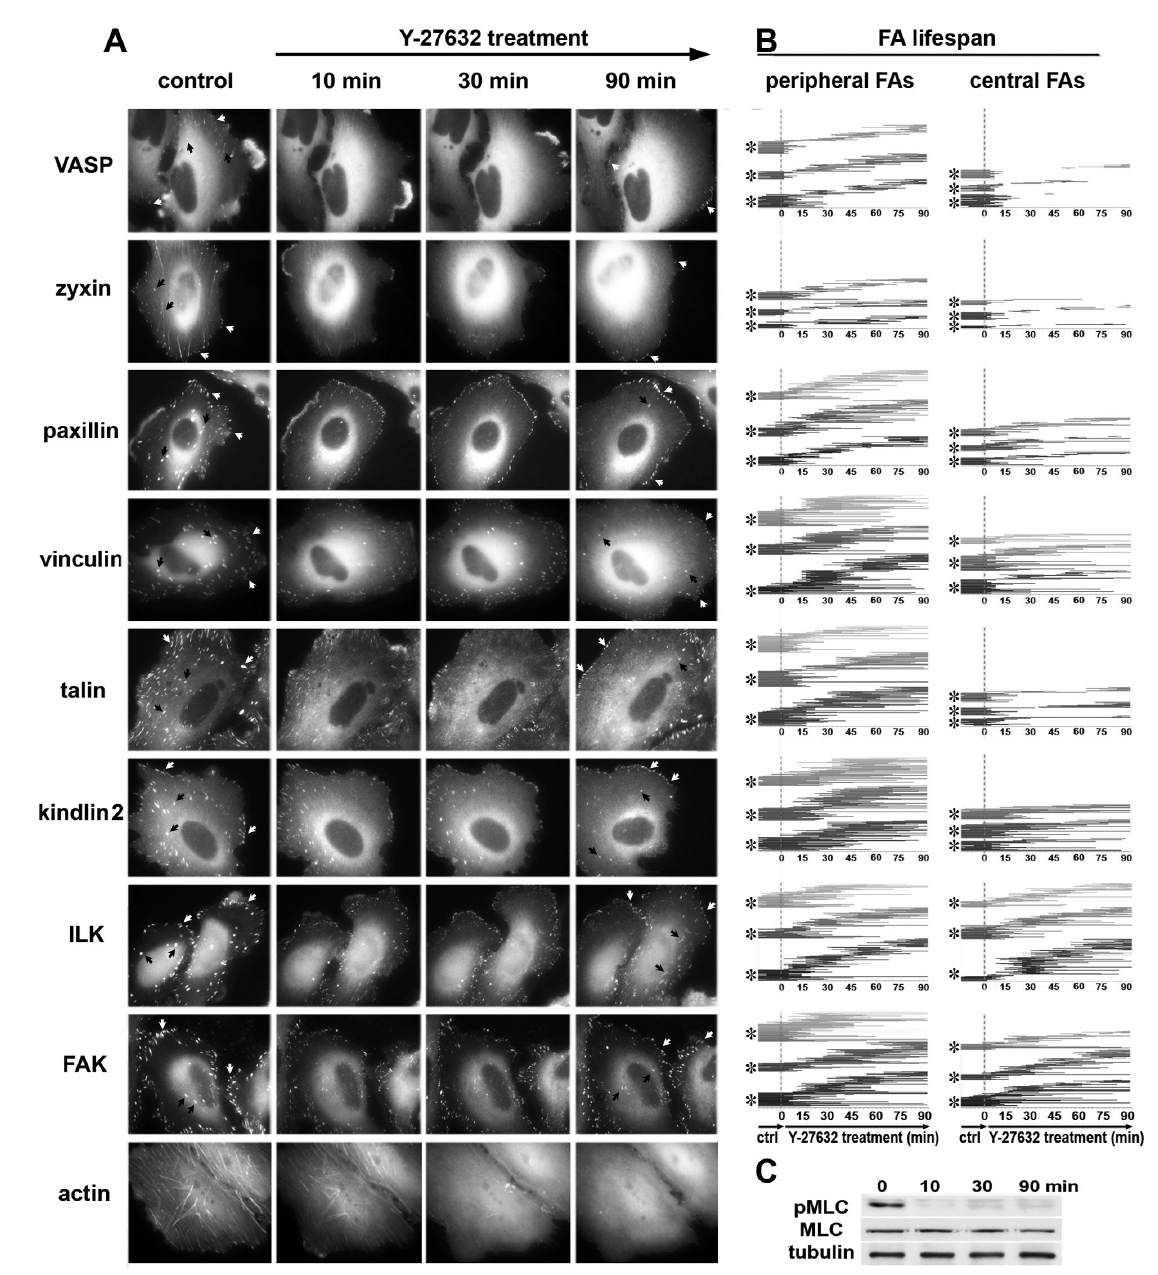
Figure 1. Effect of Y-27632 treatment on FA reorganization in HeLa JW cells. ( A ) Localization of GFP-tagged VASP, zyxin, paxillin, vinculin, talin, kindlin-2, ILK and FAK in untreated cells (control) or in the cells treated with 10 µM Y-27632 for 10, 30 or 90 min (shown are snapshots from time-lapse movies). White and black arrowheads point to peripheral and central adhesions, respectively. ( B ) FA lifespan in three different cells tagged by each of the tested proteins prior to and during Y-27632 treatment, as tracked by time-lapse video microscopy. Each line marks the lifespan of an individual adhesion site, from its formation until its complete disassembly. Individual cells are marked by asterisks on the Y axes. The vertical dashed line marks the beginning of the Y-27632 treatment. Peripheral and central FAs were analyzed separately. Note the decay of existing FAs and formation of novel FAs during Y-27632 treatment. ( C ) Western blots showing MLC and pMLC in untreated cells, or in cells treated with 10 µM Y-27632 for 10, 30 and 90 min Tubulin was used here as a loading